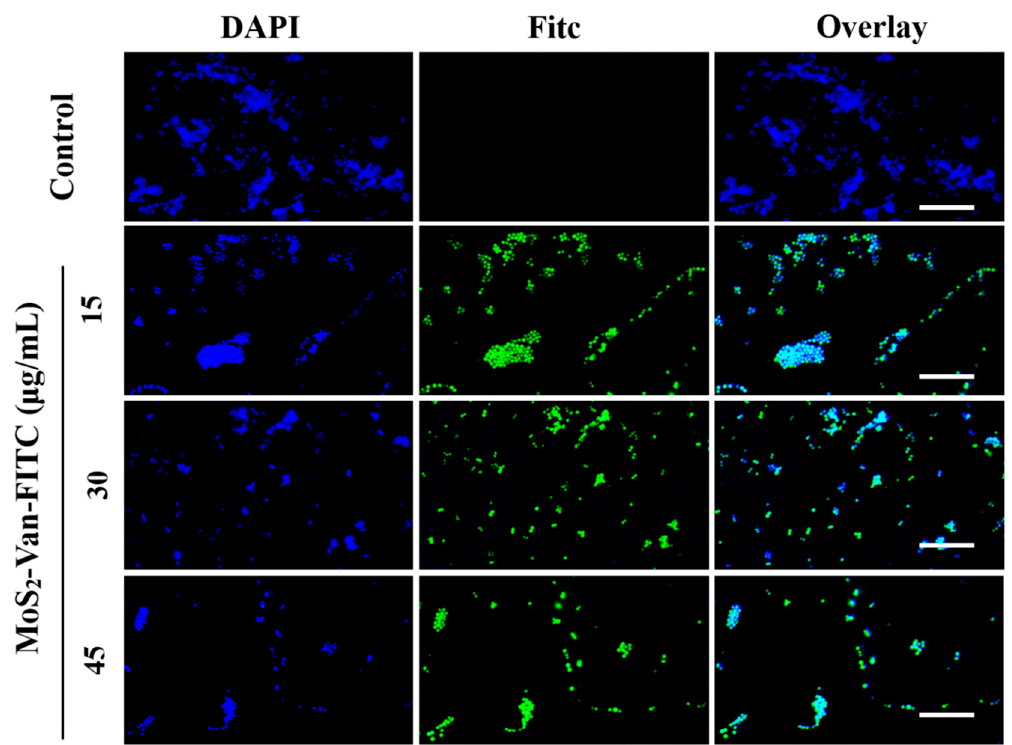
Figure 5. Fluorescence microscopy images of S. aureus cultures treated with MoS 2 -Van-FITC at var- ious concentrations (15, 30, 45 µg/mL) for 12 h. PBS served as a control for the blank group. The cells stained with DAPI for 30 min were fluorescent blue, and those stained with MoS 2 -Van-FITC were fluorescent green. Scale bar = 15 µm. (DAPI, Ex = 358 nm and Em = 461 nm; FITC, Ex = 490 nm and Em = 525 nm).